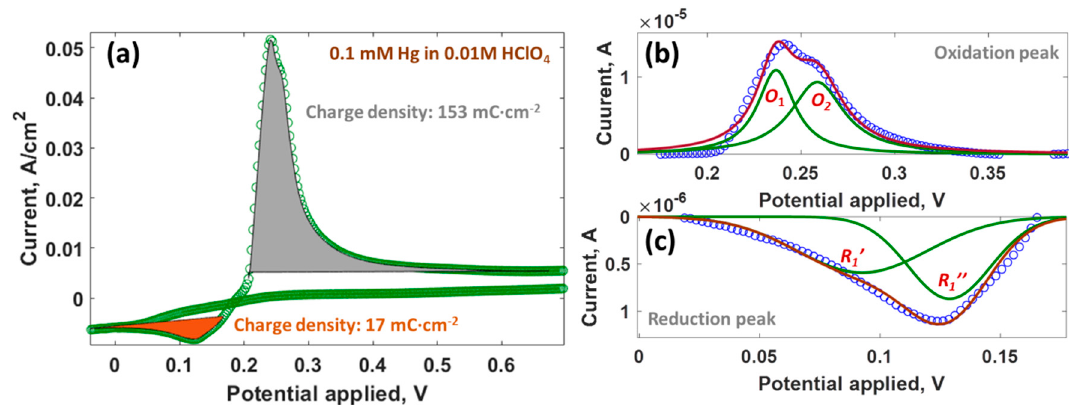
Figure 2. ( a ) Cyclic voltammogram of epitaxial graphene working electrode in 0.01 M HClO 4 electrolyte solution containing 0.1 mM Hg 2+ at v = 20 mV·s − 1 scan rate. Shaded areas correspond to the integrated charges involved in each process: mercury electroreduction (deep orange color) and anodic stripping of mercury (grey color). Deconvolution of the Hg-related stripping (oxidation) peak ( b ) and plating (reduction) peak ( c ).